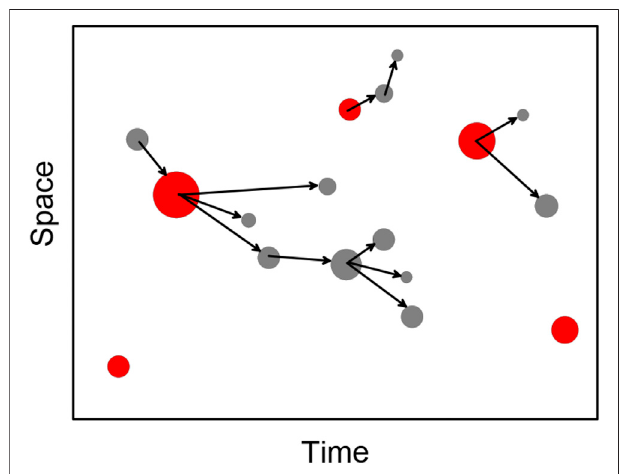
FIGURE 1 | Nearest neighbor method for declustering the earthquake catalog. Independent events are highlighted in